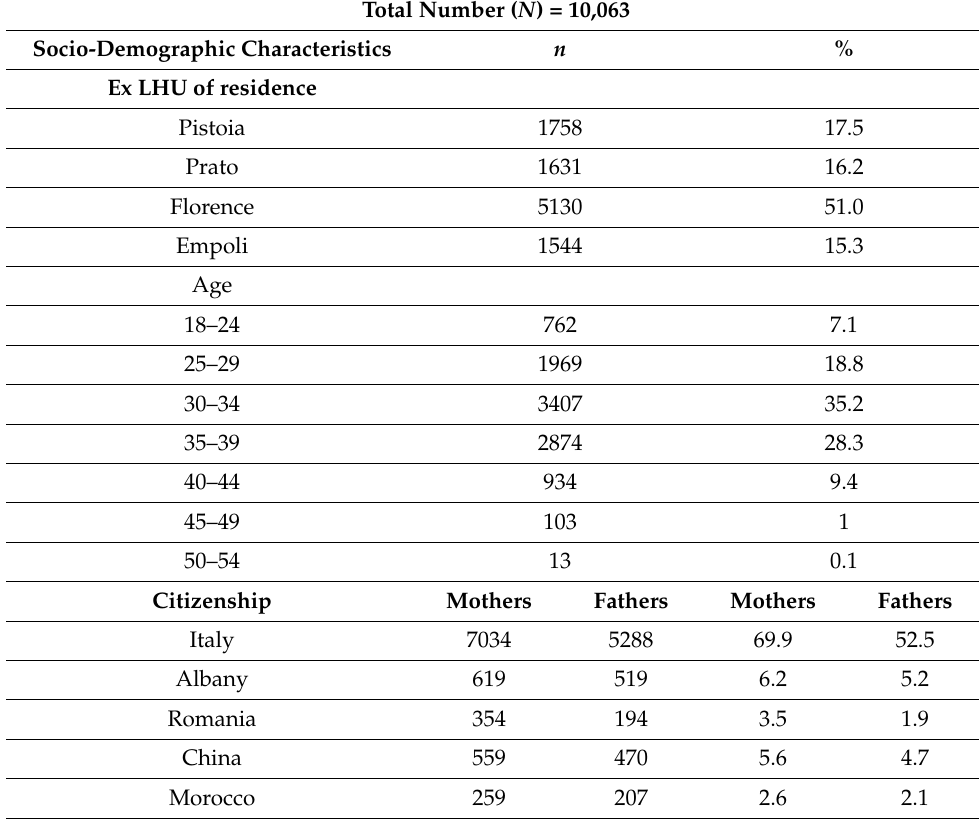
Table 1. Socio-demographic characteristics of the sample population enrolled in 2019. Frequency (%) = n / N